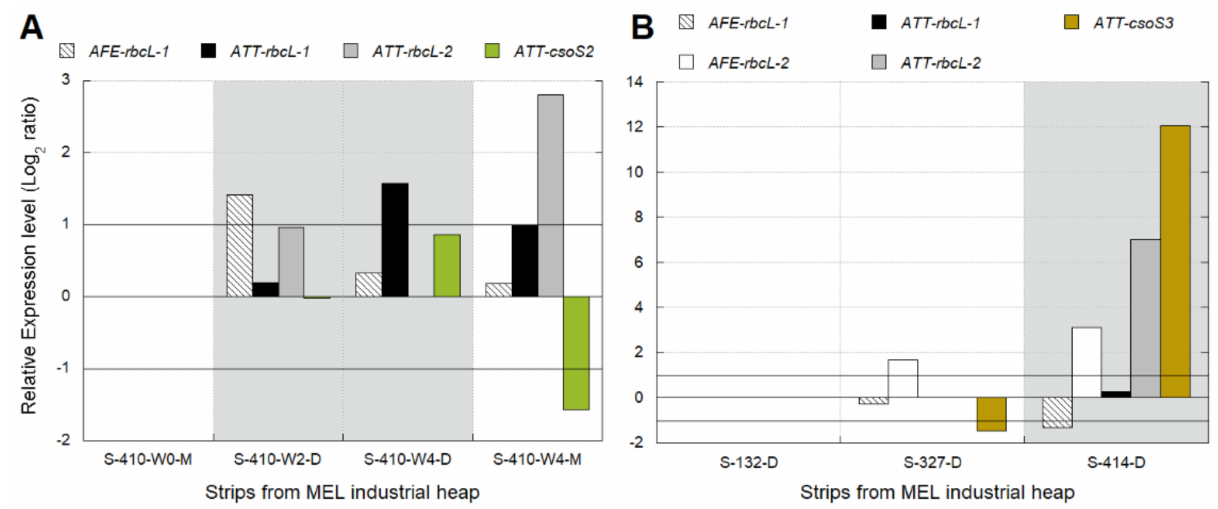
Figure 4. Transcriptional dynamics of key CBB-genes of At. thiooxidans (ATT) and At. ferrooxidans (AFE) in response to ( A ) industrial aeration interventions performed in strip S-410 and ( B ) in strips S-132, S-327, and S-414. In ( A ) 0, 2, and 4 are the three samplings performed biweekly before (0) and after (2, 4) aeration intervention in strip S-410 (Table 2). The samples D were collected from the drop located at the base of the heap. The samples M were collected at the base of the fourth lift of the heap. Gray areas show the strips without aeration (blowers turned off) in the base of the fourth lift. Significant differences in relative expression were adjusted at − 1 < Log 2 ratio < 1 (horizontal black lines). Gene expression was calculated relative to the control samples (log 0 values) that correspond in ( A , B ), respectively, to S-410-W0-M and